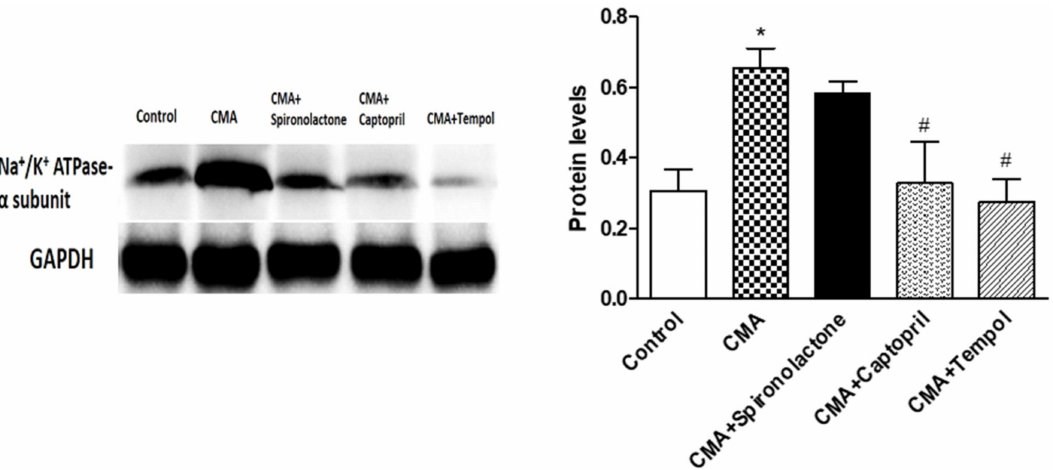
Figure 10. The protein expression of Na+/K+ ATPase in the renal proximal tubule. Each bar represents values expressed as mean ± SEM. The changes in protein concentrations were considered significant (*) when p < 0.05 (control vs. CMA) groups and ( # ) p < 0.05 (CMA vs. CMA + captopril or CMA + tempol) groups. The data were analyzed using one-way ANOVA followed by Tukey’s multiple comparison tests among all five